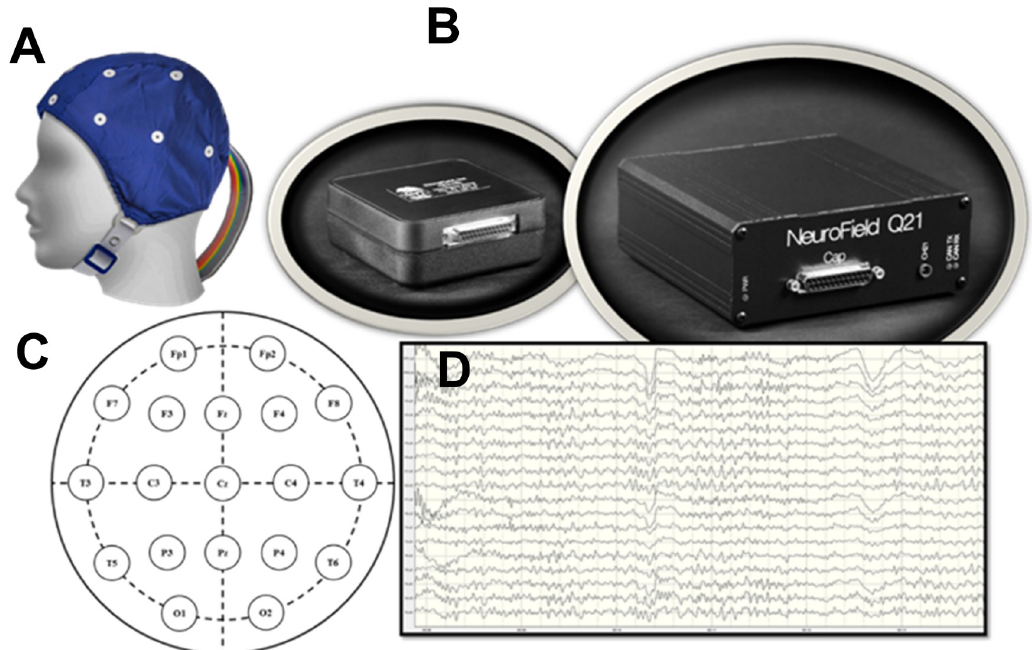
Fig 1. EEG data acquisition. ( A ) A 19-channel EEG cap (from Electro-Cap International, Inc. Eaton, OH, USA) used for collecting data. ( B ) QCheck electrode impedance monitor and Q21 amplifier (Neurofield, Inc., Bishop, CA, USA). ( C ) A diagram of the International 10–20 System to elaborate electrode placement across the scalp. ( D ) An example of a digitized EEG recording using Neuroguide software (Applied Neuroscience, Inc. Largo, FL,